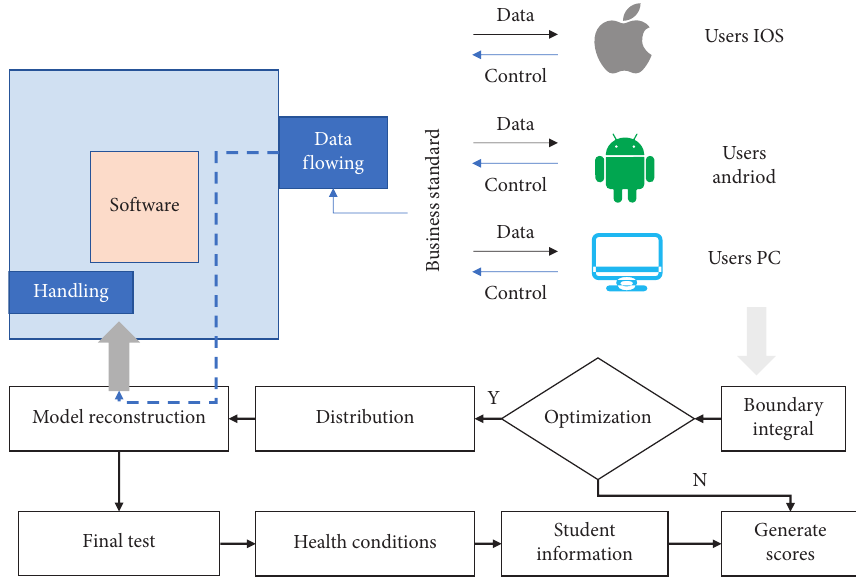
Figure 1: Feature directed graph based on user